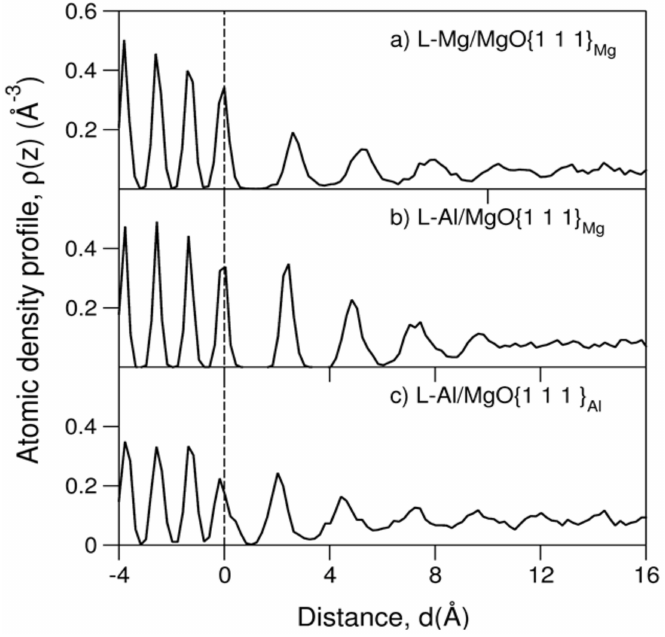
Figure 8. The Al( l )/MgO{1 1 1} Mg interface exhibits more pronounced prenucleation. Atomic density profile for ( a ) Mg( l )/MgO{1 1 1}, ( b ) Al( l )/MgO{1 1 1} Mg and ( c ) Al( l )/MgO{1 1 1} Al inter- faces [49,50,63]. The vertical dotted line represents the terminating metal